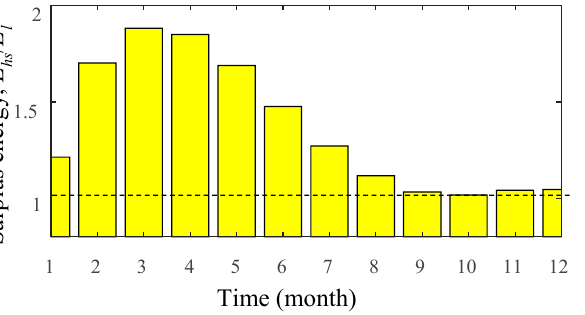
Figure 15. Monthly PV/hydro energy for a chosen system configuration ( P pv = 60% P lN , P h = 110% P lN ).